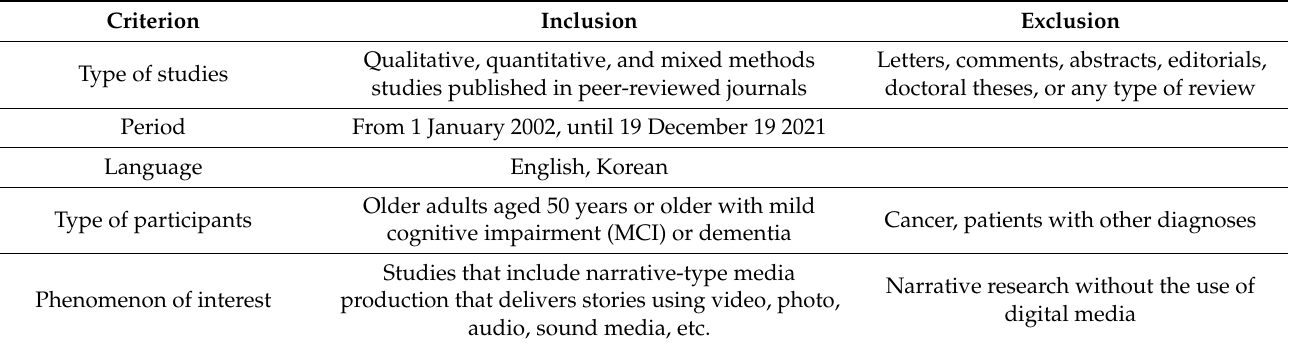
Table 1. Inclusion and exclusion